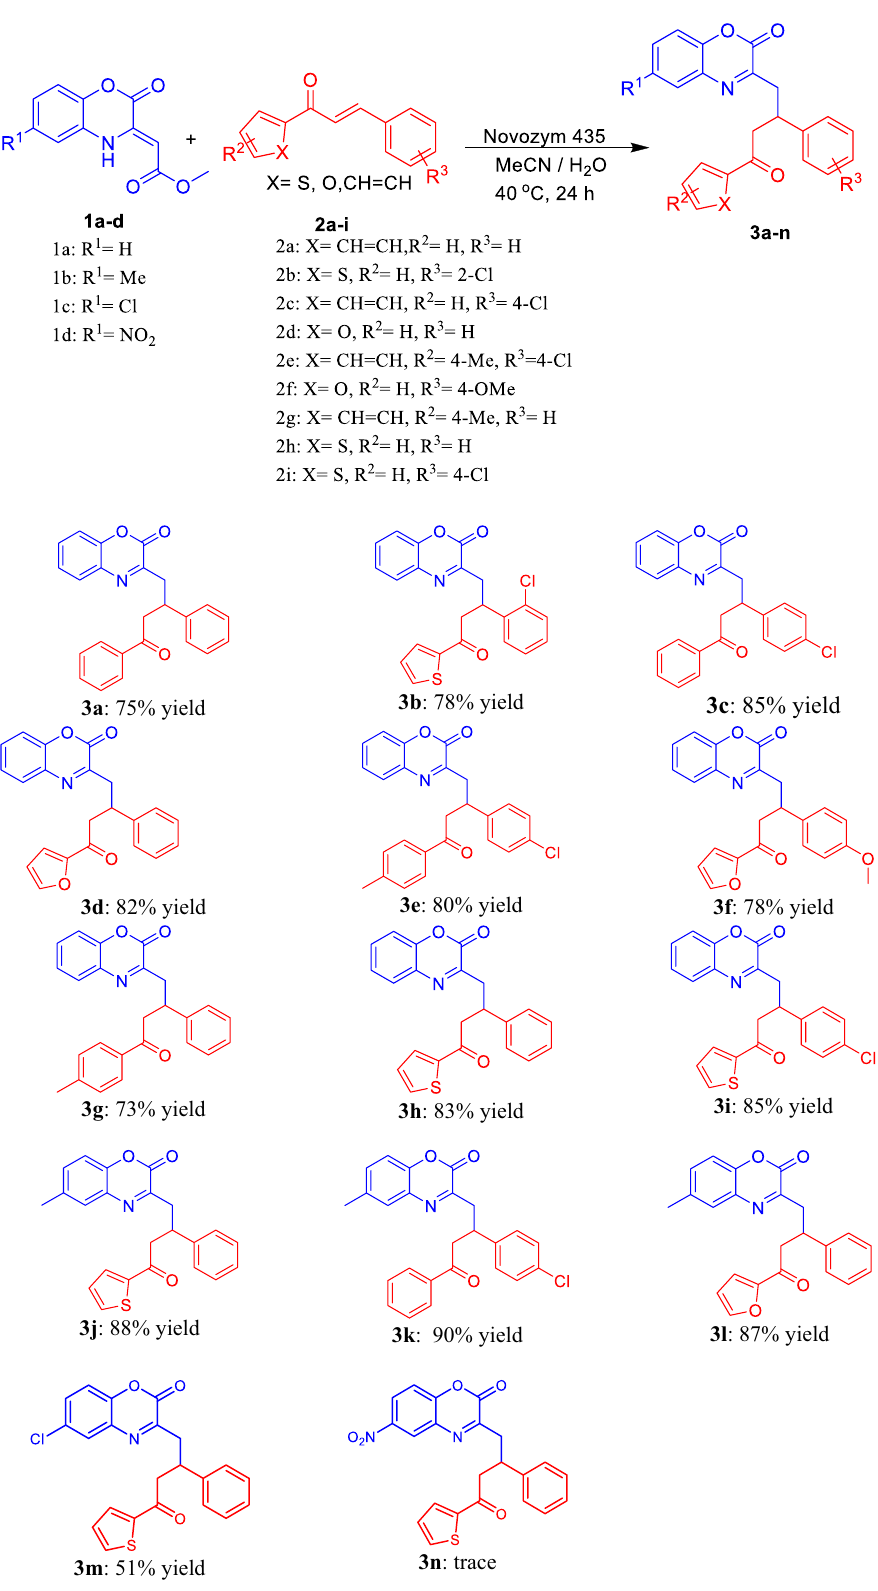
Figure 2. The reaction of 1,4-benoxazinone derivatives 1a–d (0.2 mmol) with chalcone derivatives 2a–i (0.2 mmol), MeCN (2 ml), H 2 O (40 µl), 40 °C, 24